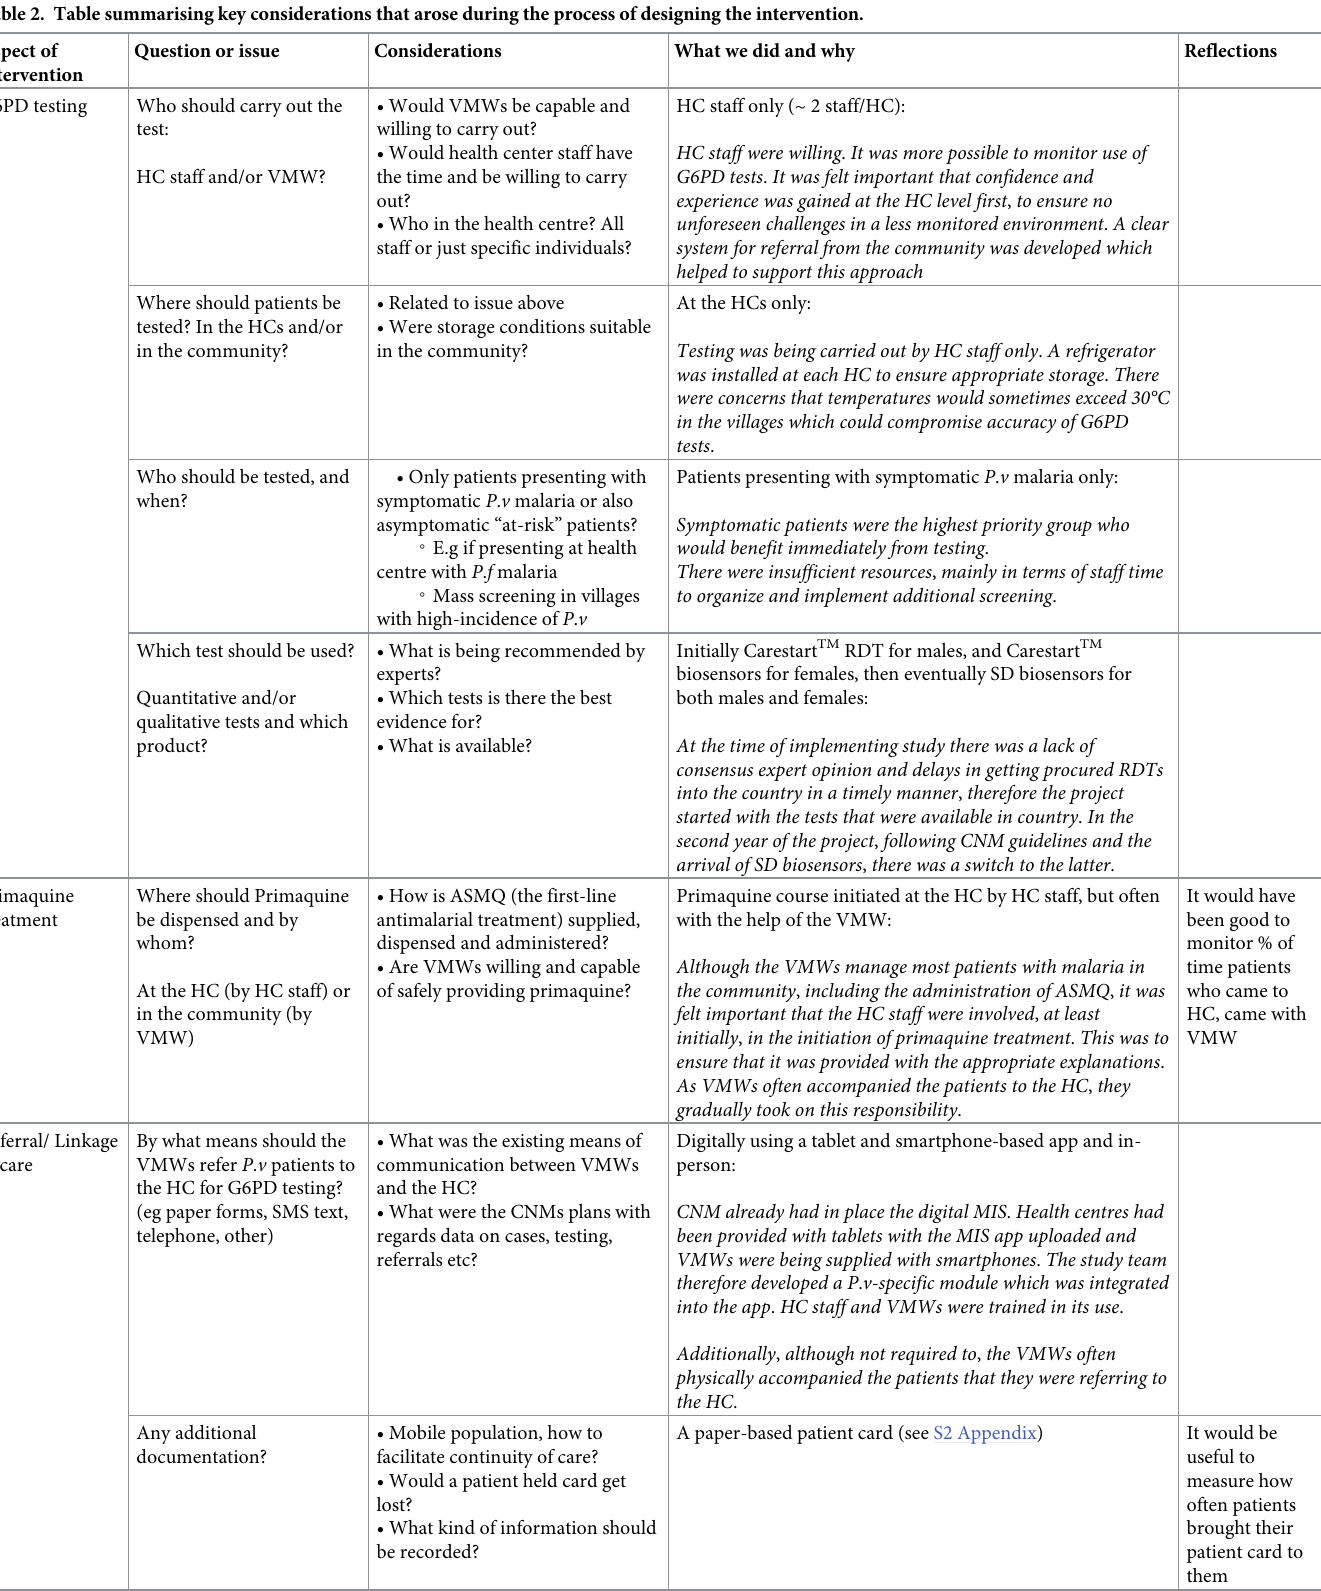
Table 2. Table summarising key considerations that arose during the process of designing the intervention. Aspect of